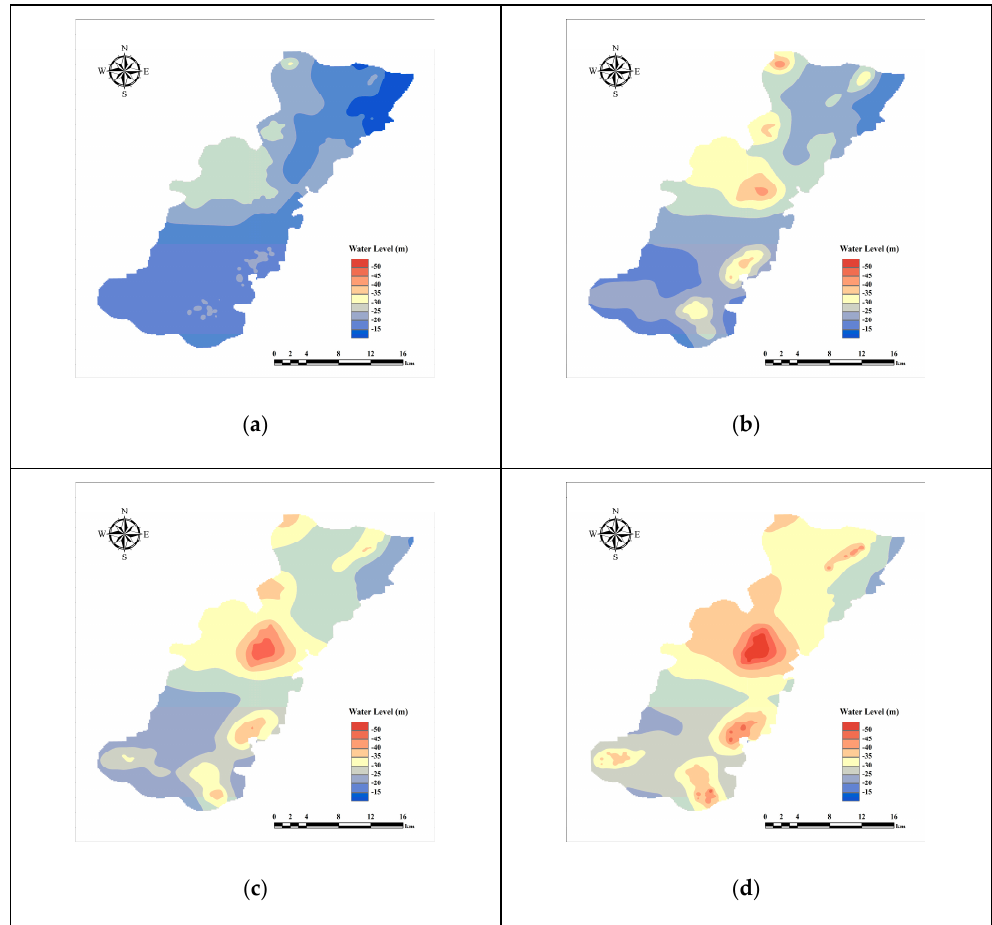
Figure 12. Groundwater flow field under high growth and enhanced water saving scheme: ( a ) at the end of 2019; ( b ) at the end of 2025; ( c ) at the end of 2030; ( d ) at the end of 2035.